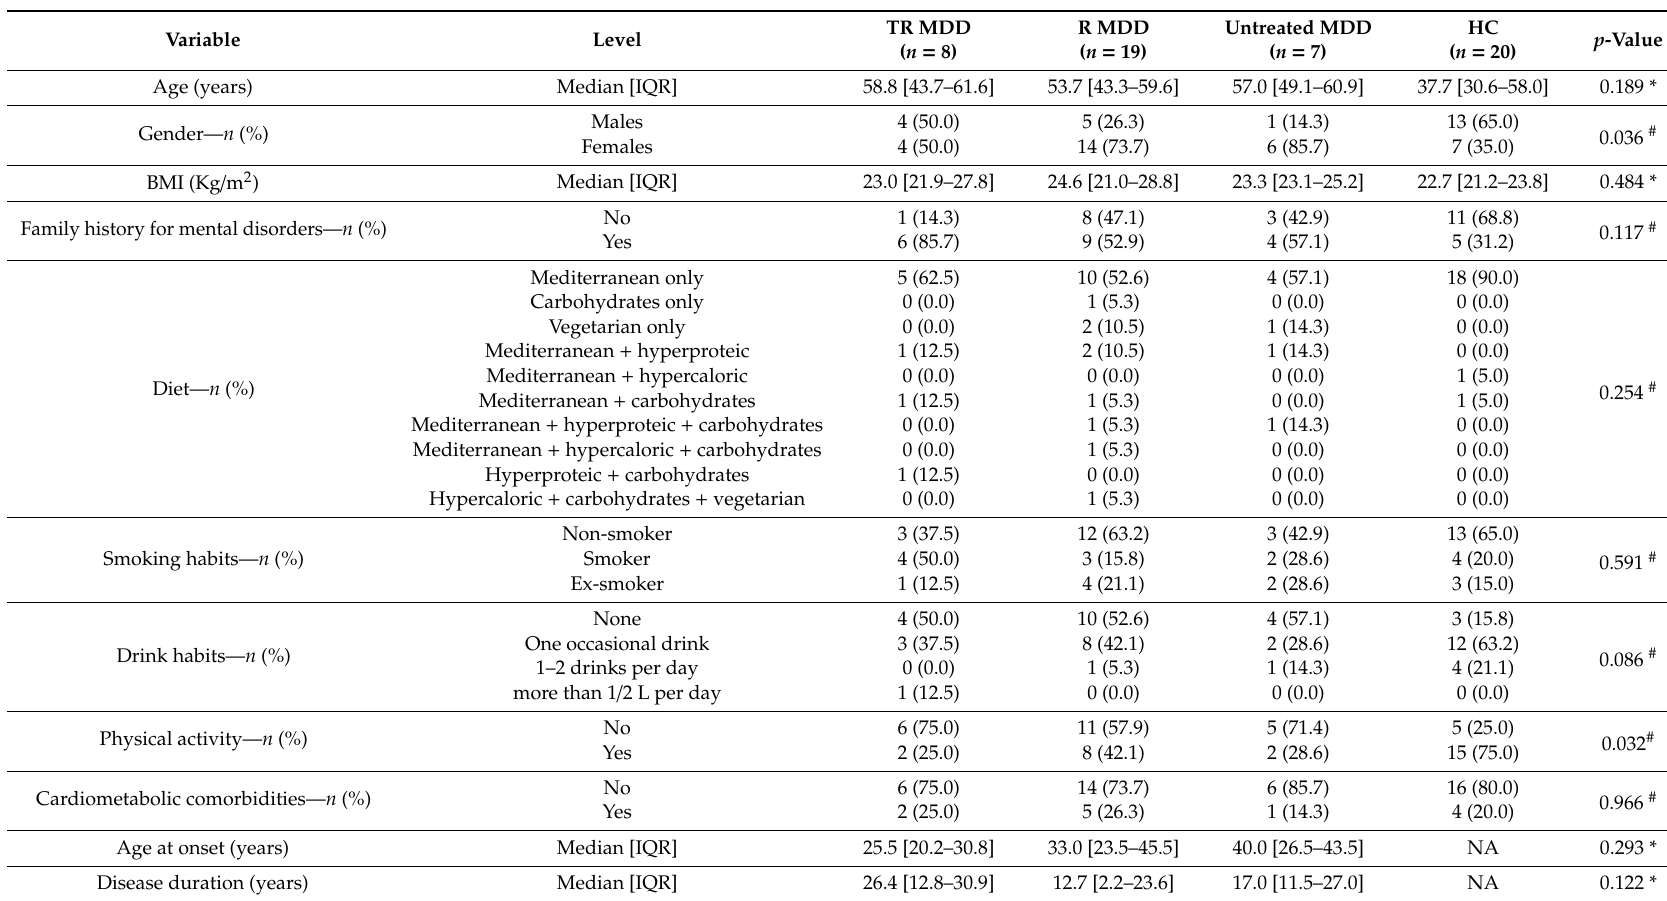
Table 1. Demographic and clinical characteristics of patients with major depressive disorder (MDD) classified according to the presence of treatment-resistant depression (TR), responsive depression (R) and healthy controls